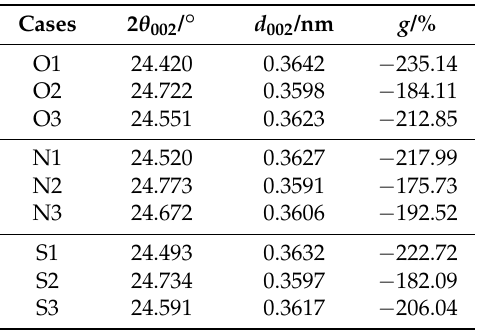
Table 3. Characteristic parameter results of XRD analysis of the soot.